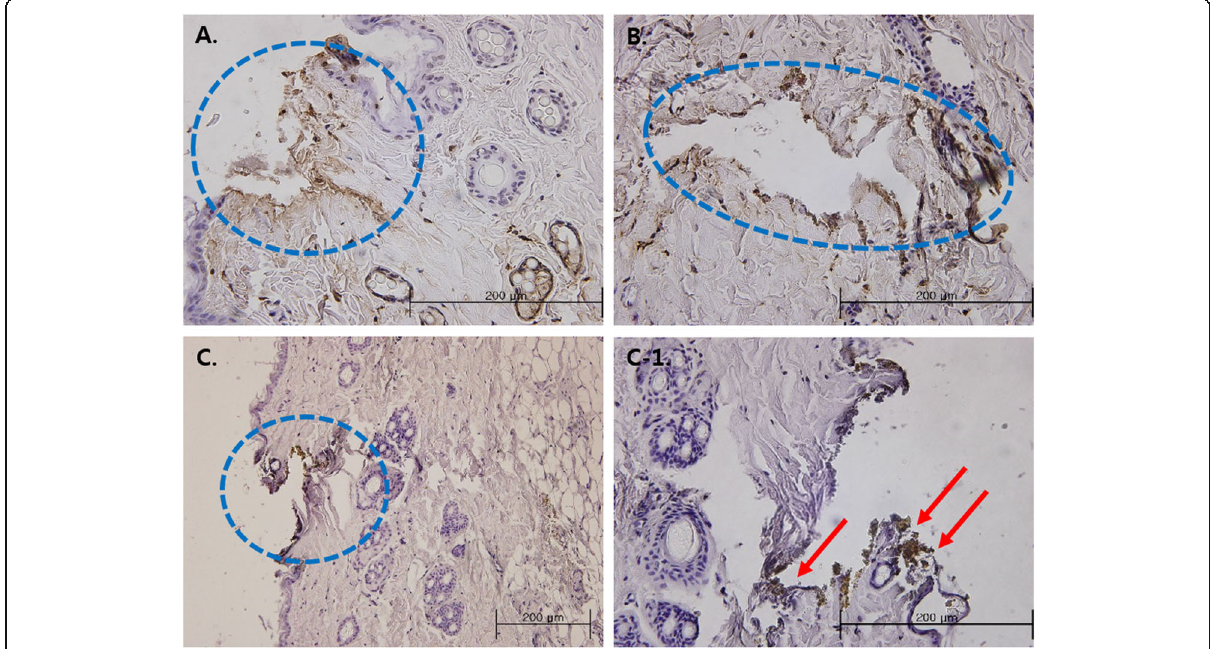
Fig. 5 Cell necrosis and corrosion byproducts in tissues. a : Non-coated 0.25-mm STS316 needle, b : Coated 0.3-mm STS316 needle, c : Coated 0.2- mm STS316 needle, C-1 : Coated 0.2-mm STS316 needle. Cell necrosis was suspected (circled) around the insertion site. Note, however, that actual cell necrosis was detected with non-coated 0.25-mm STS316 needles and coated 0.3-mm STS316 needles, but needle corrosion byproducts were only detected with coated 0.2-mm STS316 needles (arrows)